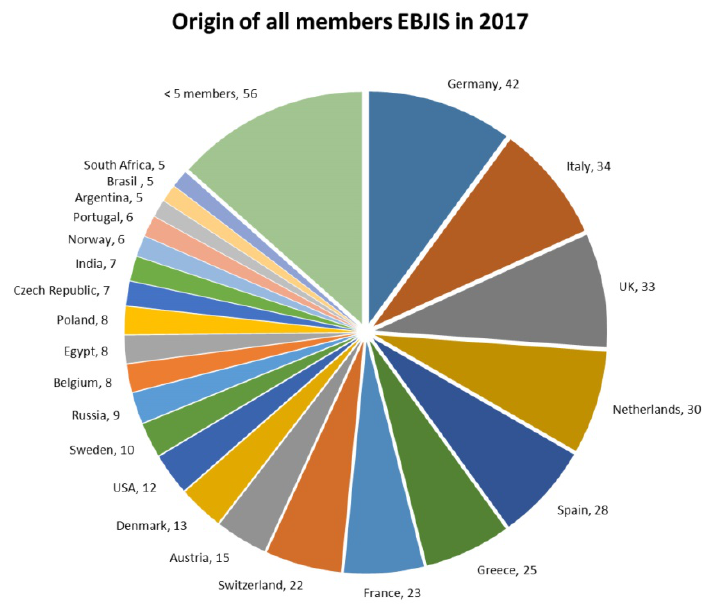
The number of members of each of the individual European countries showed striking fluctuations in the consecutive years. When a